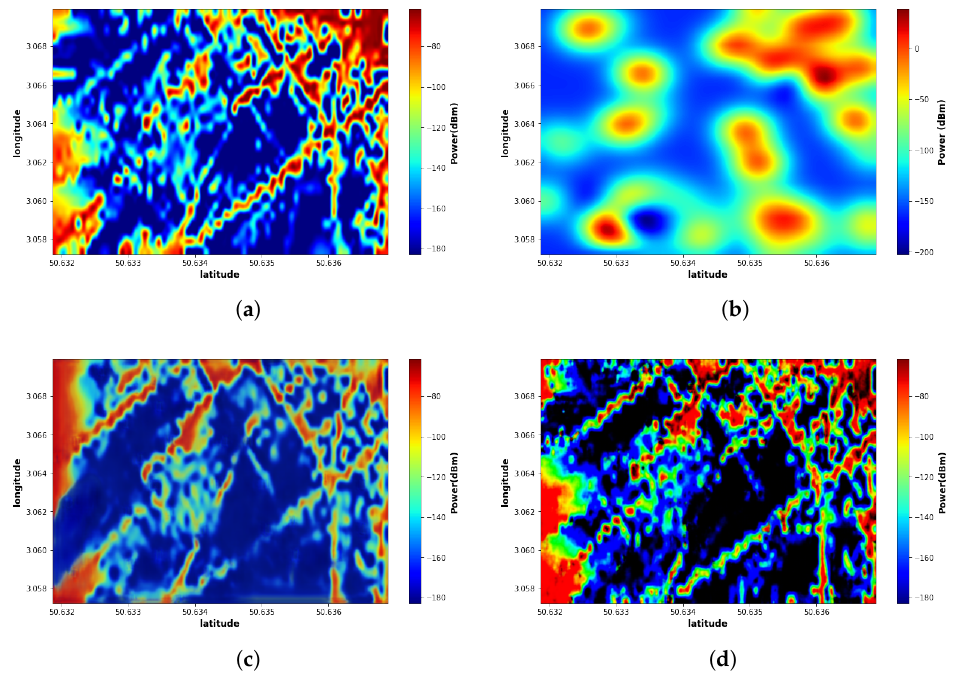
Figure 6. Comparison of Reconstructed maps of the proposed model and other different models: ( a ) Real map; ( b ) Simple kriging; ( c ) EME-Net model; ( d ) Proposed EMGAN